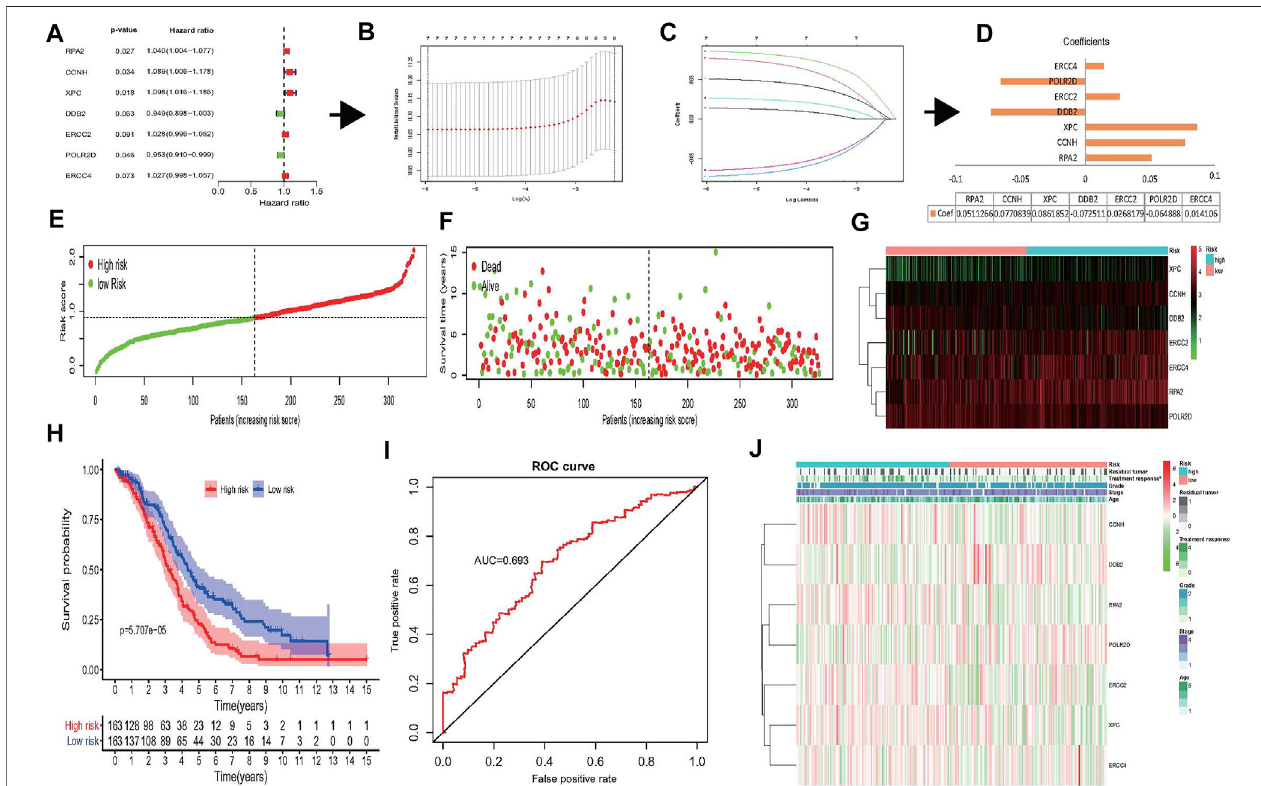
FIGURE 4 | Construction of risk signature based on seven NER-related genes. (A – D) The process of constructing the signature based on seven NER-related genes. (A) Univariate Cox regression analysis of the NER-related genes was identi fi ed seven genes that potentially correlated with OS ( p < 0.1). (B) LASSO algorithms wasusedtoidentifyandevaluatethe7-genesignatureintheTCGAHGSOCcohortandsevengeneswere fi nallyselectedandusedtodeveloparisksignaturetopredict patients prognosis. (C) LASSO coef fi cient pro fi les of the seven genes based on the TCGA HGSOC cohort. (D) The coef fi cients estimated by multivariate Cox regressionviaLASSOarepresented. (E – G) Visualizationoftheassociationoftheriskscoreswithsurvivalstatusandgeneexpressionpro fi lesinHGSOC. (H) TheOSwas remarkably worse in the high-risk group than that of low-risk group. (I) ROC curve was used to evaluate the prediction ef fi ciency of the risk signature. (J) Signi fi cant differenceswerefoundforthetreatmentresponsebetweenhigh-andlow-riskgroups.Abbreviation:NER:Nucleotideexcisionrepair;OS:Overallsurvival;LASSO:Least absolute shrinkage and selection operator; TCGA: The Cancer Genome Atlas; HGSOC: Highly-grade serous ovarian cancer; ROC: Receiver operating characteristic.